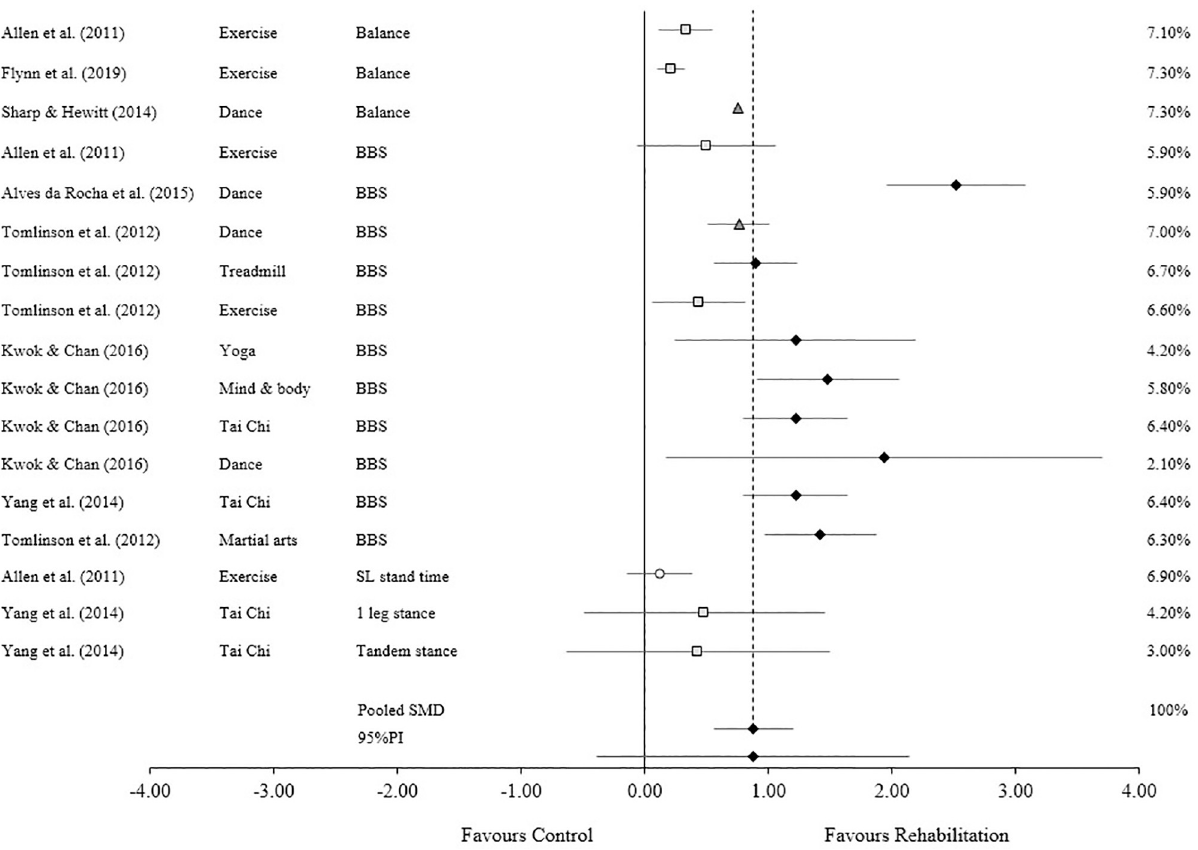
Fig 3. ocular symptoms/ocular symptoms (balance). (cid:2) Trivial effect ■ Small effect ▲ Moderate effect ◆ Large effect. Forest plot to illustrate the standardized mean difference (SMD) (95% confidence intervals) for studies evaluating the effect that active rehabilitation has on measures of balance. BBS: Berg Balance Scale; SL: Single leg.